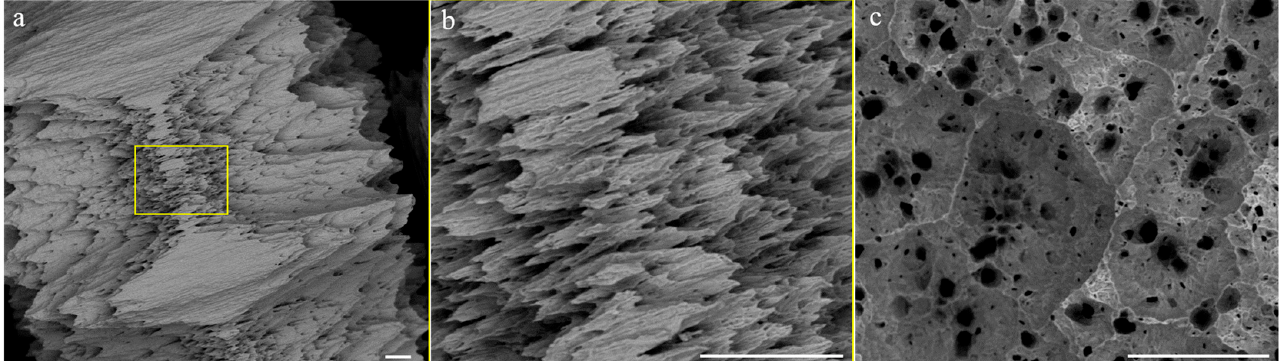
Figure 7. Backscattered SEM images of Mo pellet as obtained after 120 min of reaction time. Lateral ( a , b ) and basal ( c ) overview of Mo pellet presenting evident localized corrosion. ( b ) Zoom of Figure 7a showing the corrosion lines run along the lateral surface until reaching the middle of the barrel-shaped pellet. All scale bars are of 50 µm.